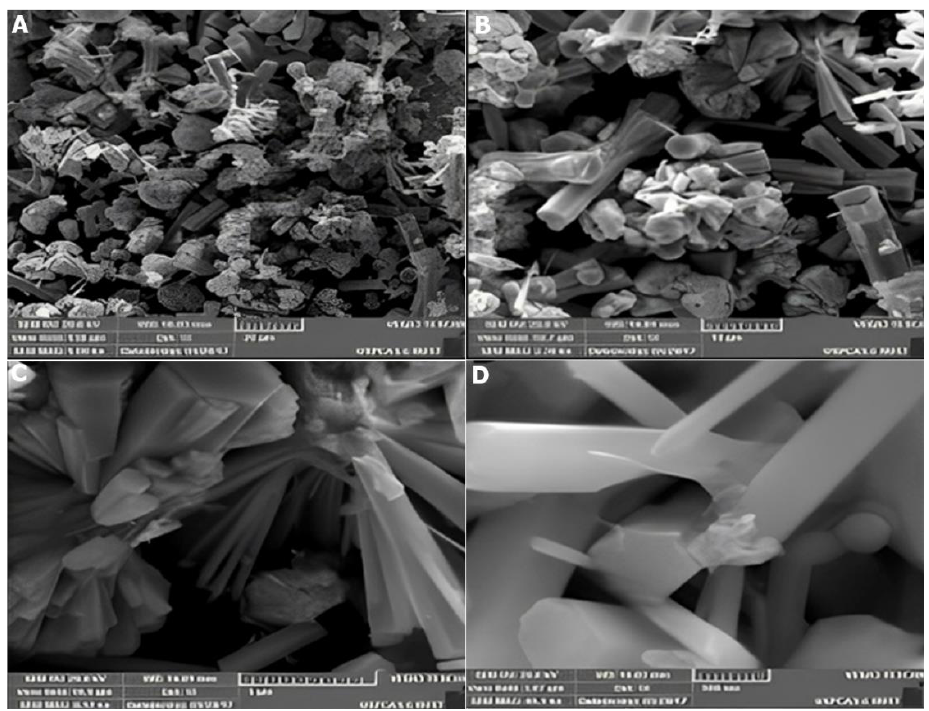
Figure 14. SEM images of ZnO-CNTs + GO nanocomposites: ( A )—20 µm, ( B )—10 µm, ( C )—5 µm, and ( D )—0.5 µm.